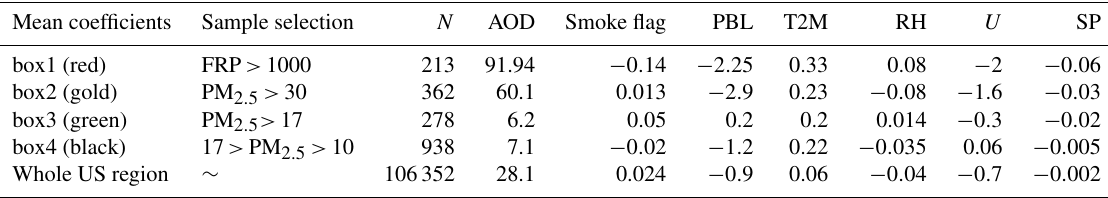
Figure 4. (a) EPA ground-observed PM 2 . 5 distribution over the US averaged from 9 to 25 August 2018. (b) GWR-predicted 17d mean PM 2 . 5 distribution. (c) Difference map of predicted ground PM 2 . 5 of the 17d mean values between 2018 and 2011. PM 2 . 5 values equal to or larger than 60µgm − 3 are shown as the same color (red). Note that the D-PM 2 . 5 has a different color scale to make the negative values more apparent (blue). Table 4. Coefficients of different